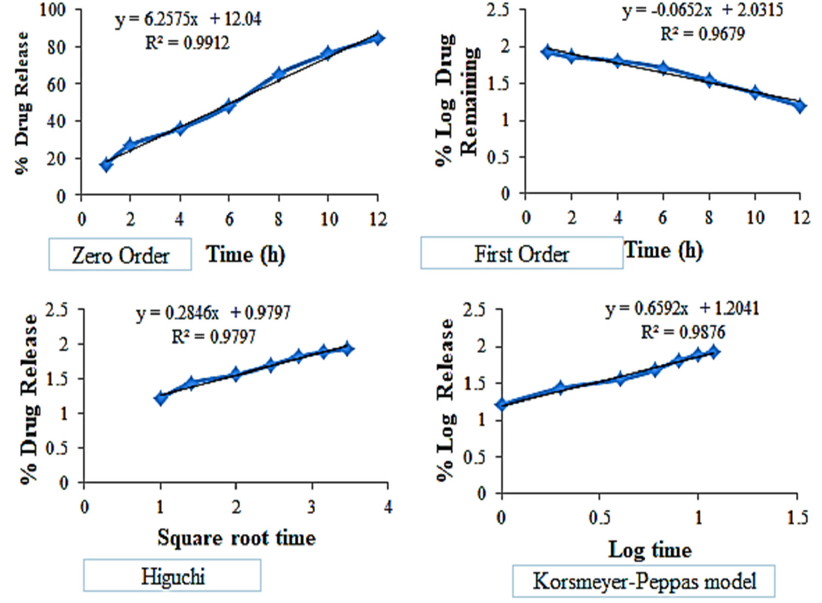
Figure 9. In vitro release kinetic model for EZL ‐ PNsopt.